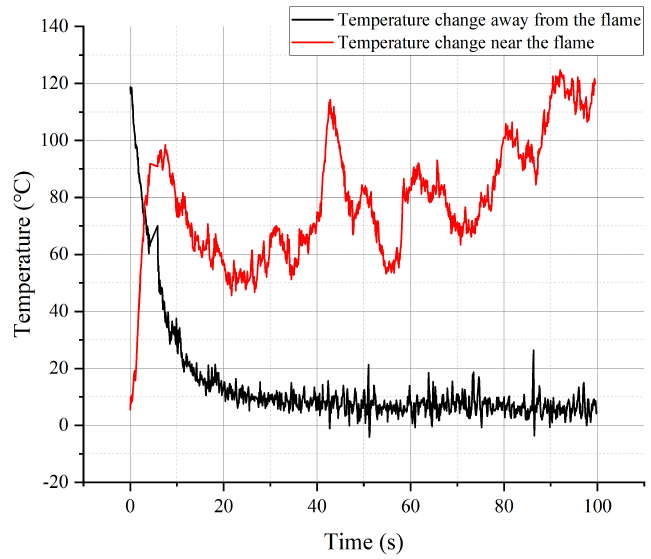
Figure 16. Flame temperature variation curve measured by sensing